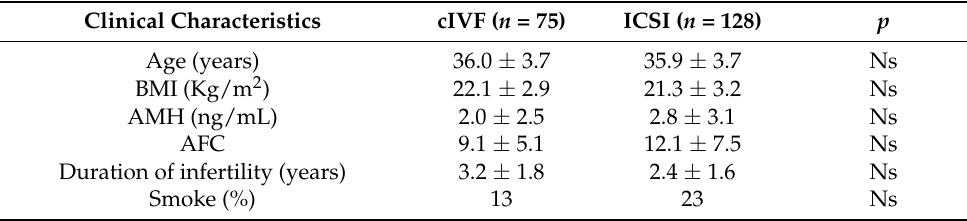
Table 1. Clinical characteristics of 203 patients who underwent ART treatment in the presence of endometrioma, either conventional IVF (cIVF; n = 75) or ICSI ( n = 128). No statistically significant difference in the baseline clinical features was observed between groups.